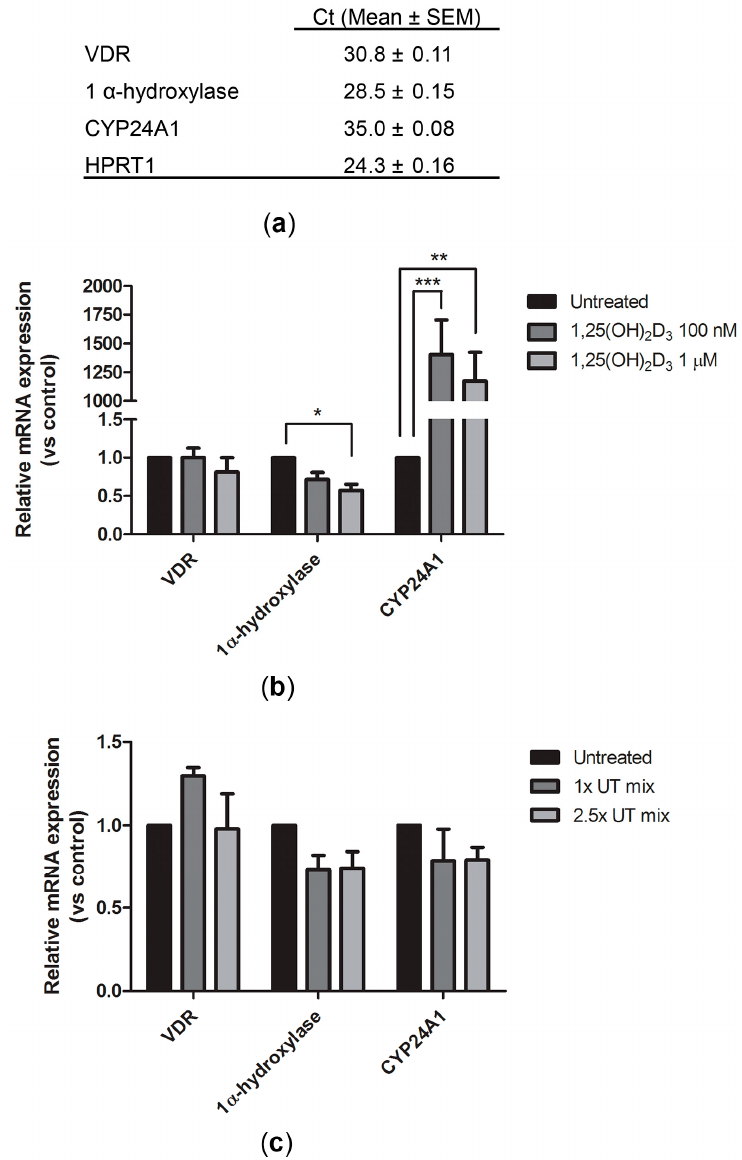
Figure 1. Expression of genes related to vitamin D function and metabolism in ciPTEC-OAT1. ( a ) Cycle threshold ( C t ) values (expressed as mean ± SEM) reflecting expression levels in basal conditions of vitamin D receptor (VDR), 1 α -hydroxylase and CYP24A1. Relative mRNA expression of three genes in ciPTEC-OAT1 after 24 h exposure to ( b ) 100 nM and 1 µ M of 1,25(OH) 2 D 3 or ( c ) 1 × and 2.5 × UT mix, compared to control (untreated ciPTEC-OAT1). Three independent experiments were performed in duplicate. * p < 0.05, ** p < 0.01, *** p < 0.001 (One-way ANOVA, Dunnett’s multiple comparison test).